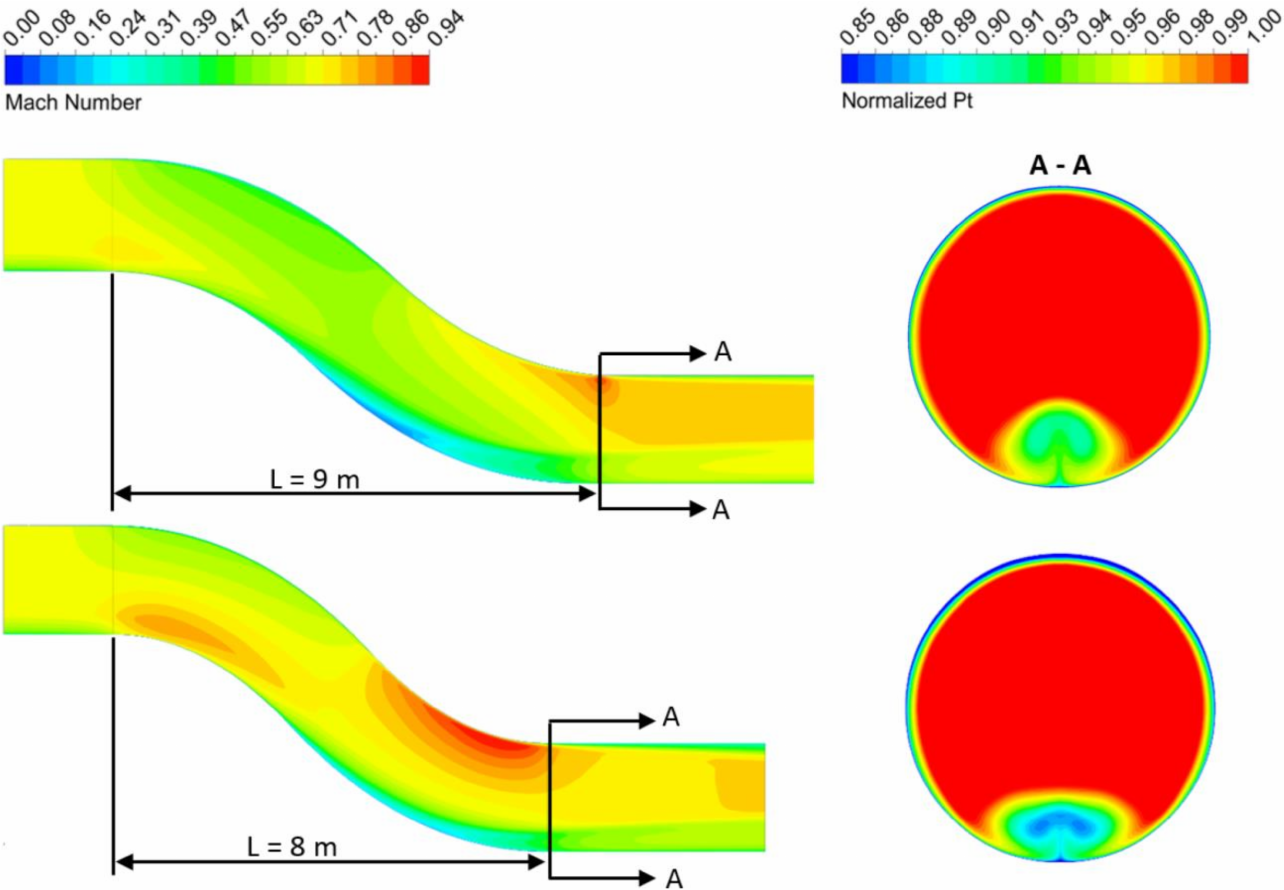
Figure 17. Comparison of the symmetry plane Mach number contours and normalized total pressure distribution at the engine inlet (top: optimal PR, bottom: undeformed